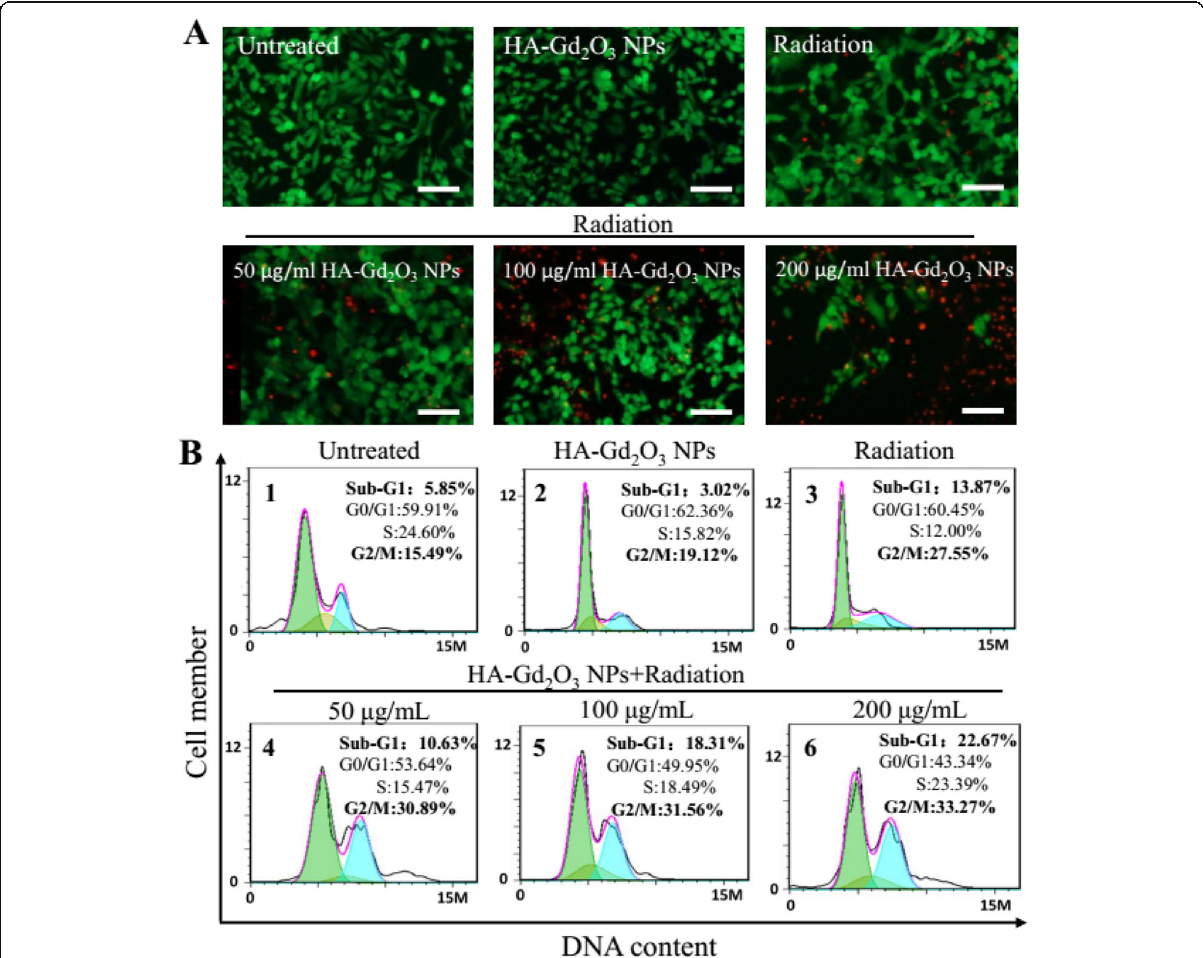
Fig. 7 Radiation dose enhancement of HA-Gd 2 O 3 NPs. a Live-dead staining of HepG2 cells. Green (fluorescein diacetate stain) = live cells, red (propidium iodide stain) = dead cells. Scale bars = 200 mm. b The cell cycle distribution after different treatments were analyzed by quantifying DNA content using flow cytometry